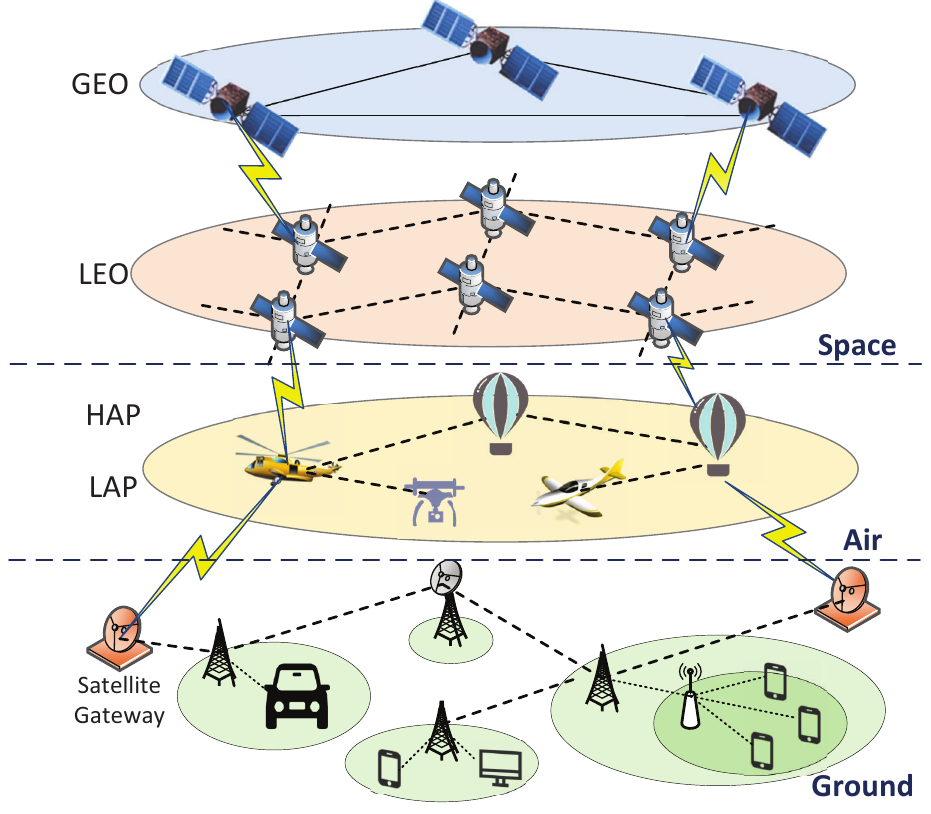
Figure 1. The typical architecture of the